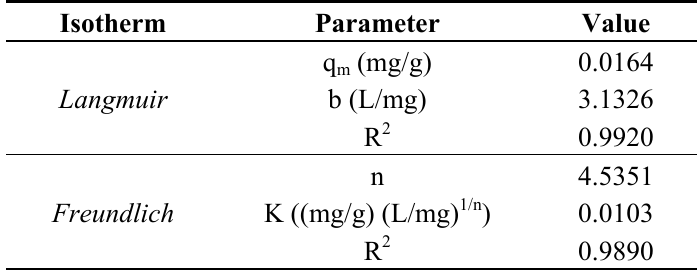
Table 1. Langmuir and Freundlich parameters (C V = 50 mL, shaker speed = 150 solution